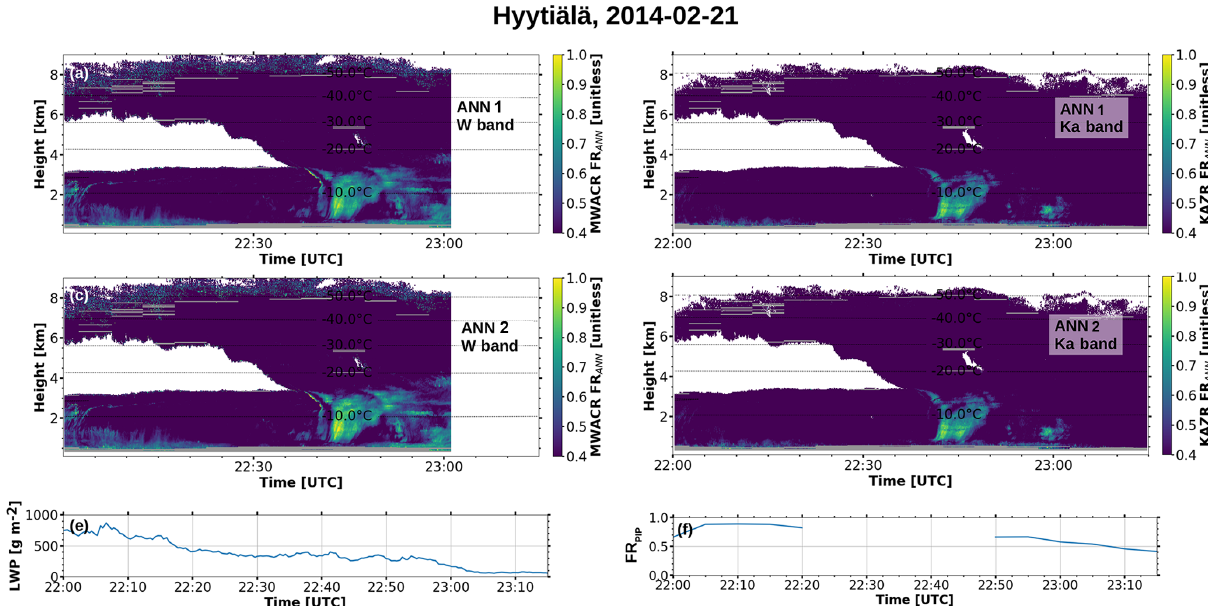
Figure 4. Riming during the focus case on 21 February 2014 as predicted by (a, b) ANN 1 trained on MWACR and KAZR data, respectively (Ze, MDV, SEW, and skewness), and (c, d) ANN 2 trained on MWACR and KAZR data, respectively (Ze, SEW, and skewness). (e) Liquid water path obtained from microwave radiometer measurements. (f) FR PIP measured during the event. Pixels with EDR above the threshold of 10 − 3m 2 s − 3 are masked in gray in panels (a) – (d) . Table 2. Test set performances for the three different ANN ensembles for the complete test set and a subset of it containing only high ( > 0 . 5) target values.